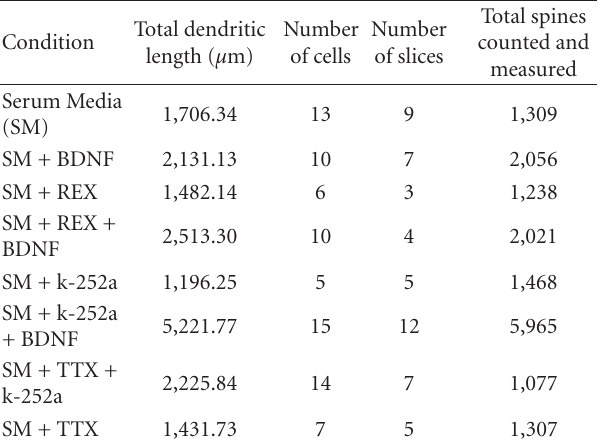
Table 2: Summary of total dendritic length, cells, slices, and individual spines sampled for the quantitative dendritic spine